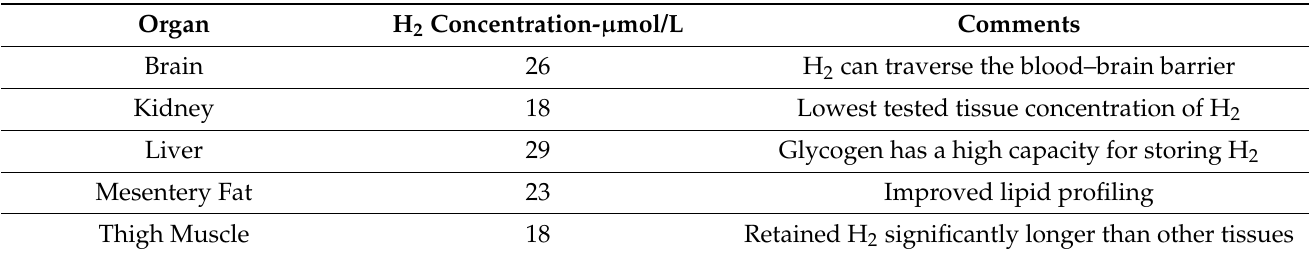
Table 1. Distribution of molecular hydrogen in visceral organs of male Sprague–Dawley rats [72].